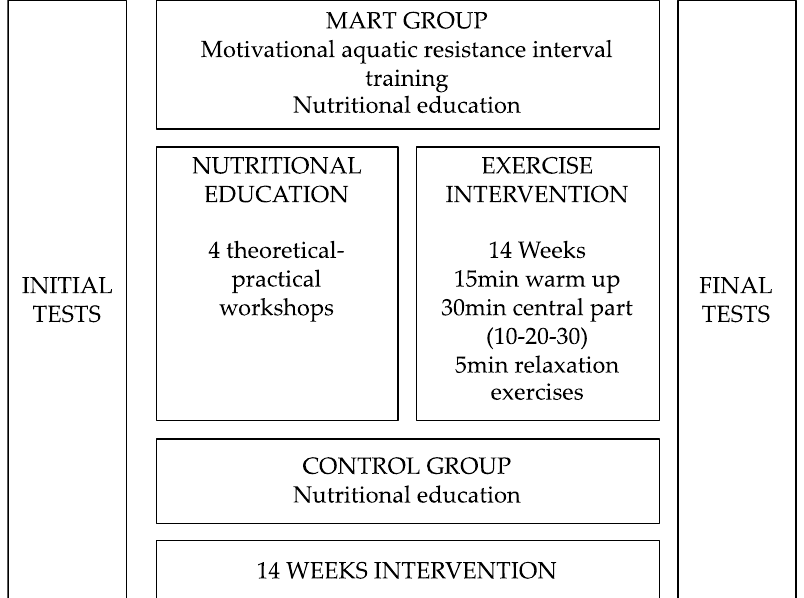
Figure 2. Summary of intervention.